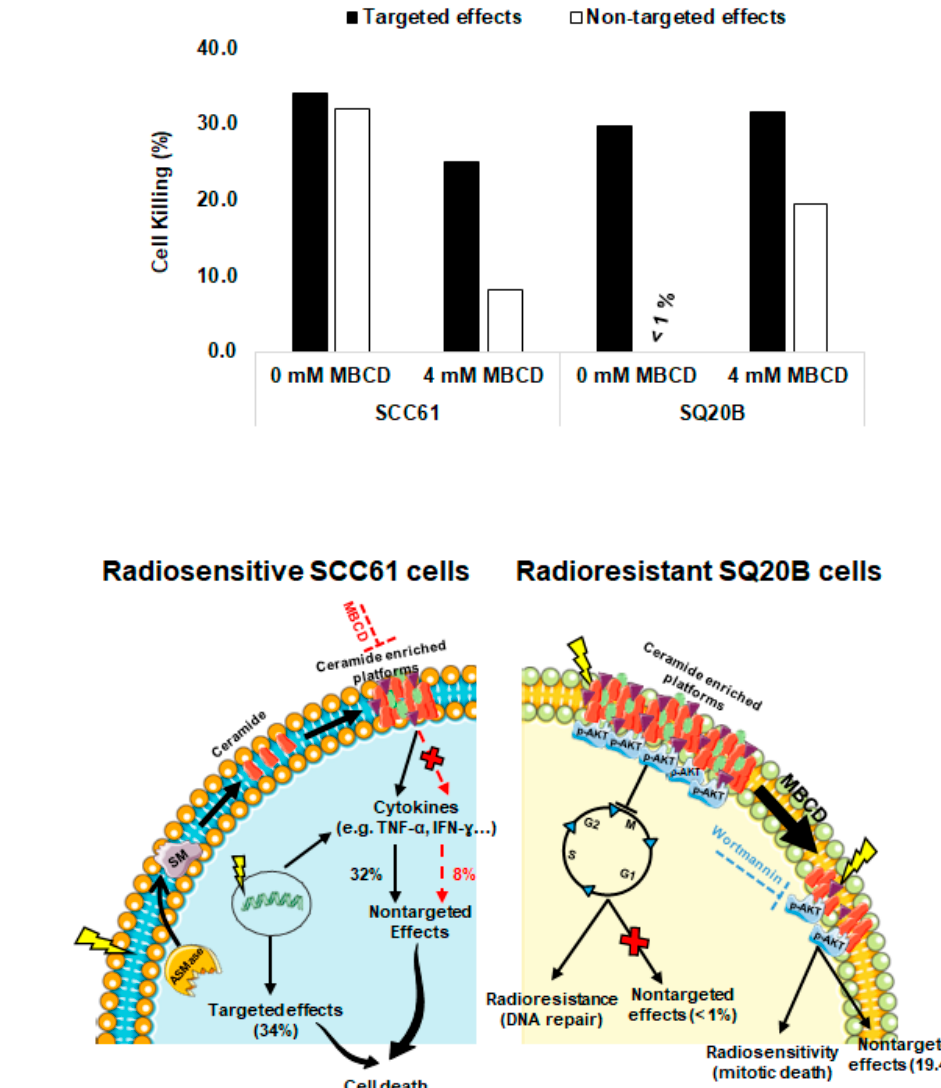
Figure 7. Contribution of targeted and nontargeted e ff ects of radiation in radiosensitive SCC61 and radioresistant SQ20B cells: ( A ) the percentage of targeted and nontargeted e ff ects to cell killing related or not to lipid raft disruption was determined using a Bliss independence mathematical model as described. ( B ) In radiosensitive SCC61 cells, irradiation led to targeted e ff ects via the production of DNA damage or via activation of ASMase, which induces sphingomyelin hydrolysis to ceramide and phosphorylcholine and participates in the formation of ceramide-enriched platforms. These platforms can promote di ff erent signaling pathways including cytokine release, leading to nontargeted cytotoxicity. In the presence of a lipid raft disruptor (MBCD), these nontargeted e ff ects were strongly reduced. Conversely, in radioresistant SQ20B cells, the preexistence of ceramide-enriched domains provides a suitable environment for AKT activation and contributes to resistance to radiation and the absence of nontargeted e ff ects by promoting G2 / M cell cycle arrest, allowing DNA repair. The disruption of lipid rafts produces AKT dephosphorylation and suppresses arrest in the G2 / M phase cell cycle, leading to cell death and apparition of nontargeted e ff ects. Similarly, inhibition of AKT survival pathways by wortmannin showed an increase of cell death and bystander response.